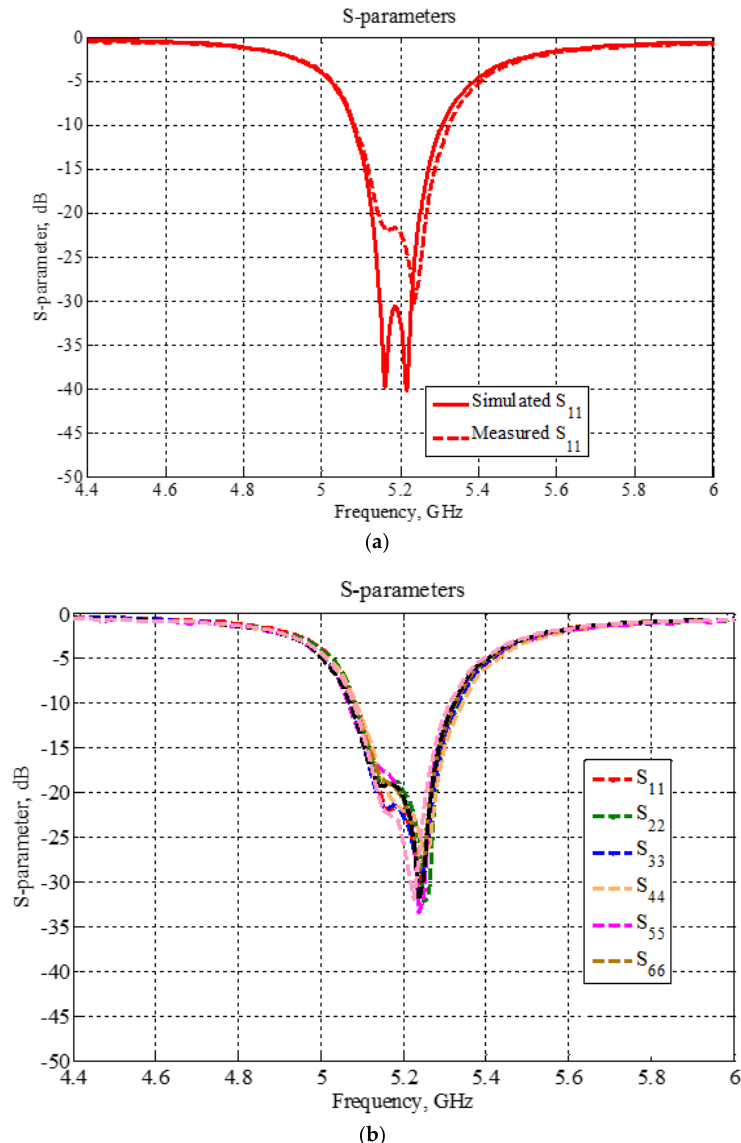
Figure 10. Test environment of the proposed RF EH ( a ) The Rx receiver board is connected to a G watch, ( b ) Chip LED, and ( c ) Mobile phone. Reprint with permission [4775431338148]; 2020, IEEE.